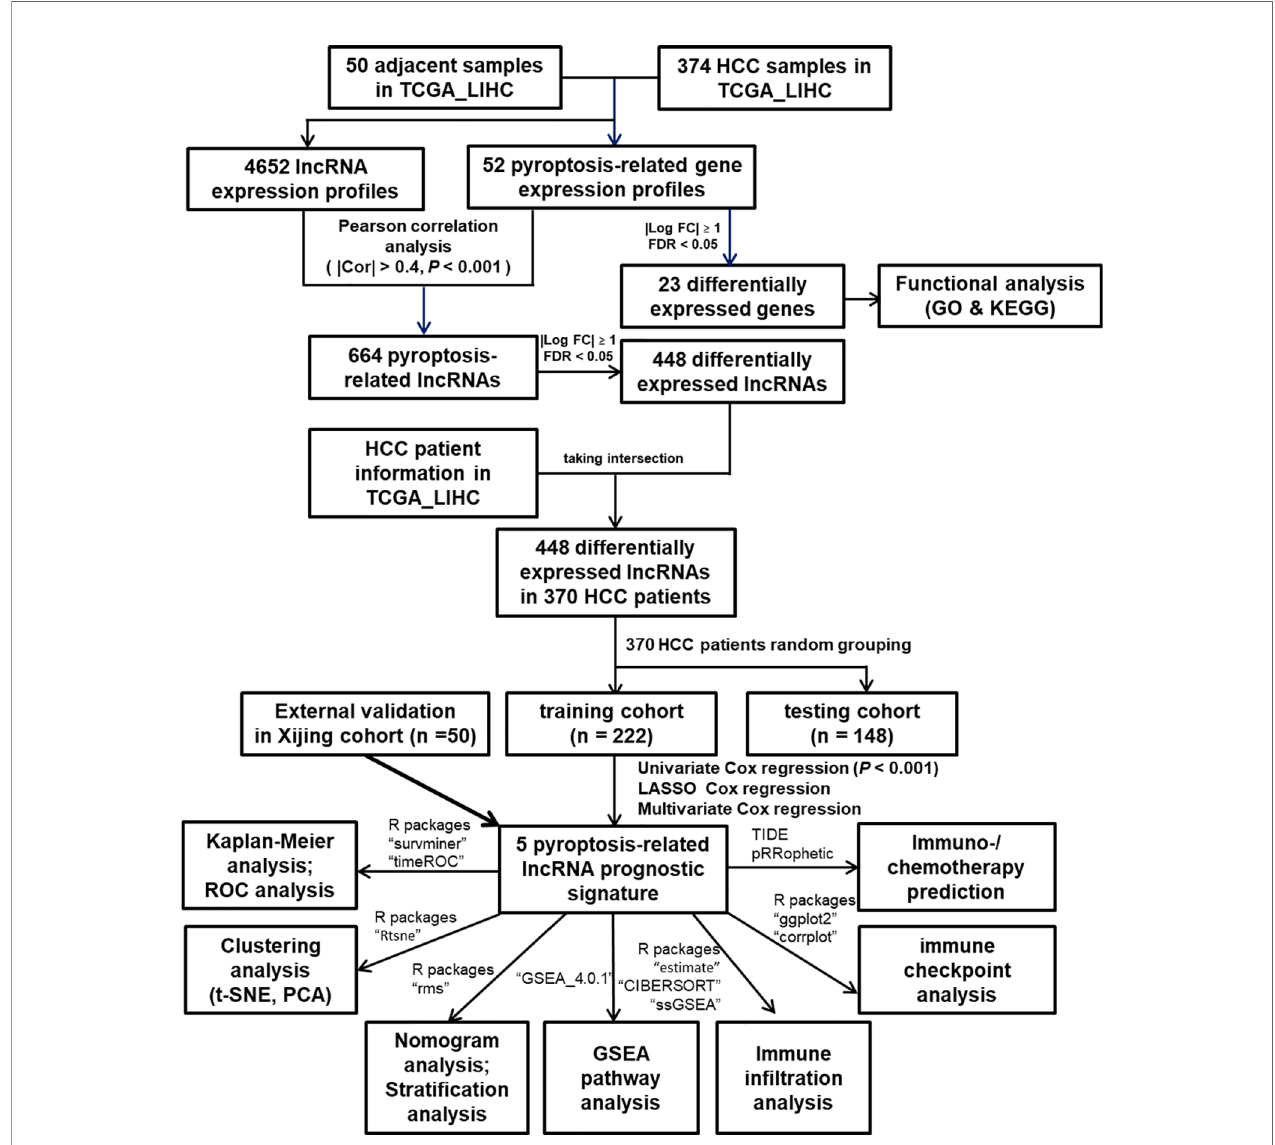
FIGURE 1 | Flowchart of the study